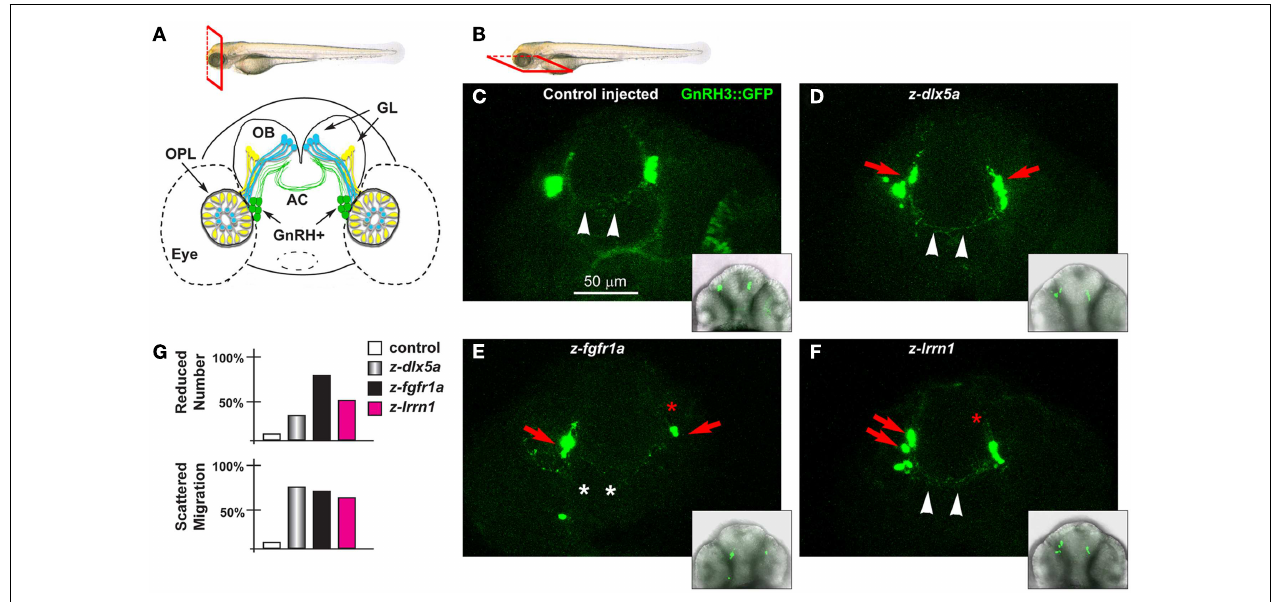
anti- z-dlx5a MO (D) , with anti-z- fgfr1a MO (E) , or with anti- z-lrrn1 MO (F) . Insets on the lower right of each panel is a low-magnification merged micrograph (bright field and GFP fluorescence) of the higher magnification one. Red asterisks indicate reduced number of cells, red arrowheads indicate scattering and delayed cell migration, white arrowheads indicate the anterior commissure, white asterisks indicate absence of anterior commissure. (G) Quantification of the observed phenotypes, as percent over the total number of GFP + embryos examined with each